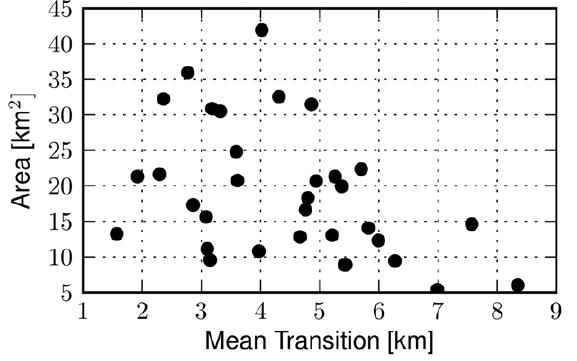
Figure 5. City area sizes and mean movement lengths. Scatter plot of the area of a city, measured in square kilometers, versus its mean human transition in kilometers. Unlike place density, the area of a city does not seem strongly related to the mean length of its transitions ( R 2 ~ 0 : 19 ). To measure the area of a city we have segmented the spatial plane around its geographic midpoint in squares of size 250 | 250 m 2 . The area of a city has been defined as the sum area of all squares that feature at least five places.